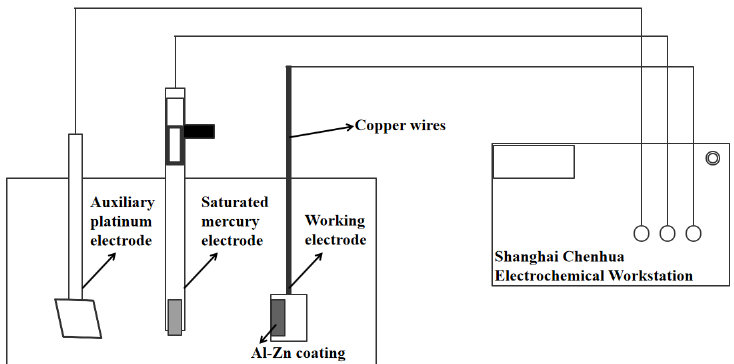
Figure 3. Schematic diagram of coated electrode and electrochemical test system.